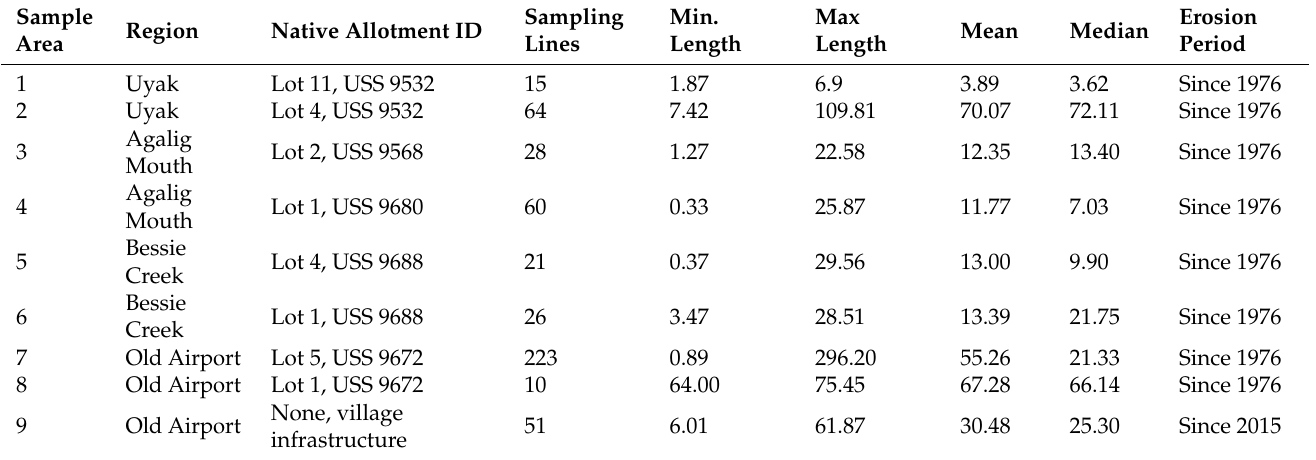
Table 2. A list of sample areas measured across four regions near